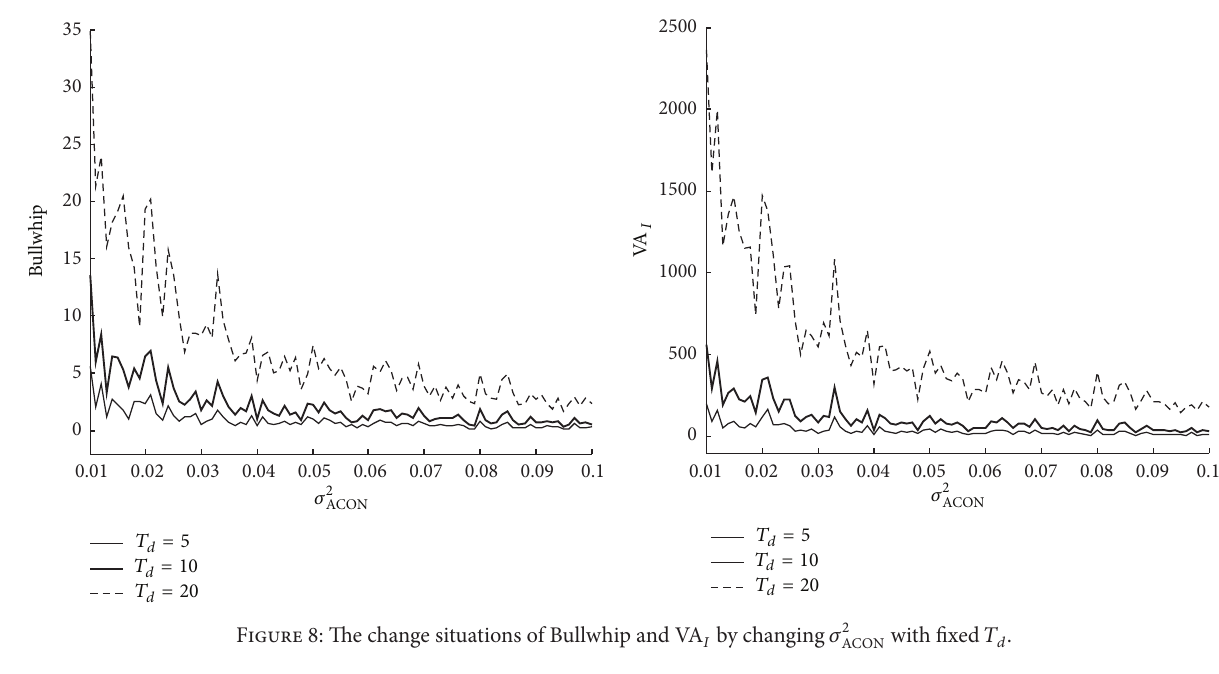
Figure 8: The change situations of Bullwhip and VA 𝐼 by changing 𝜎 2 ACON with fixed 𝑇 𝑑 .